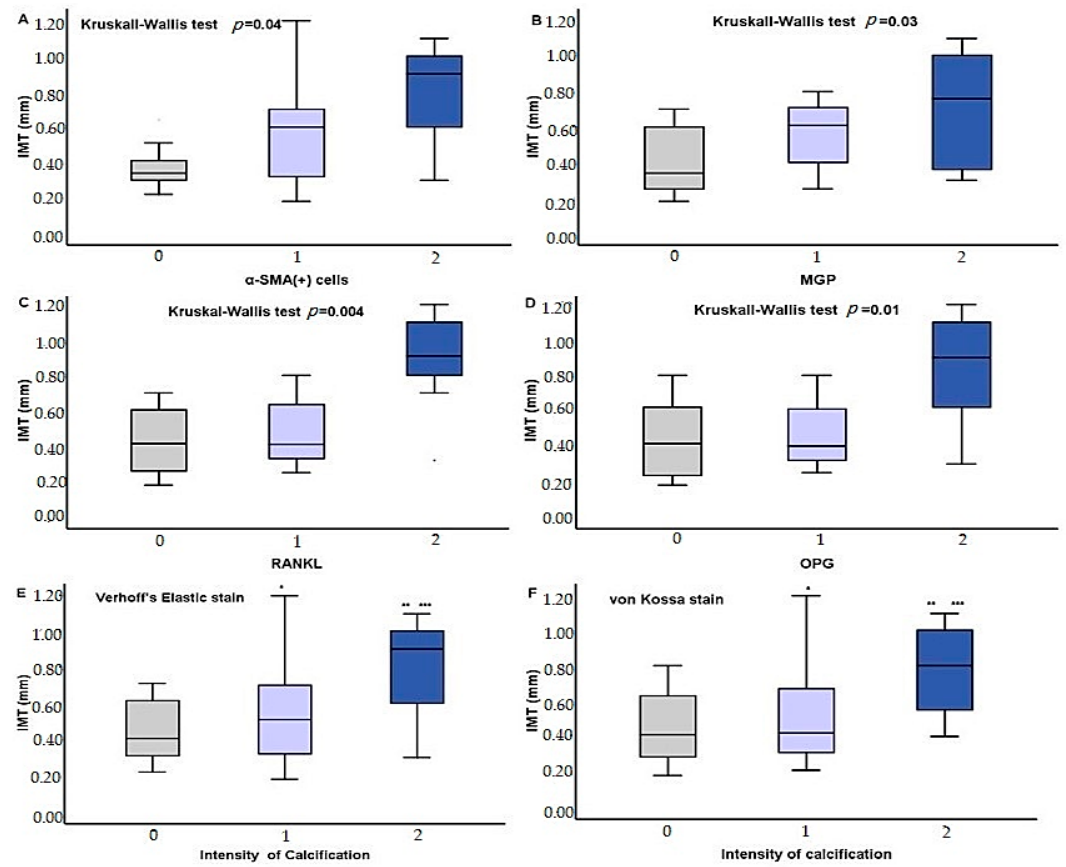
Figure 4. Differences in IMT cells according to the severity of radial artery infiltration by a-SMA(+) cells ( A ), MPG ( B ), RANK ( C ), OPG ( D ), and intensity of calcification based on Verhoff’s elastic ( E ) and von Kossa ( F )